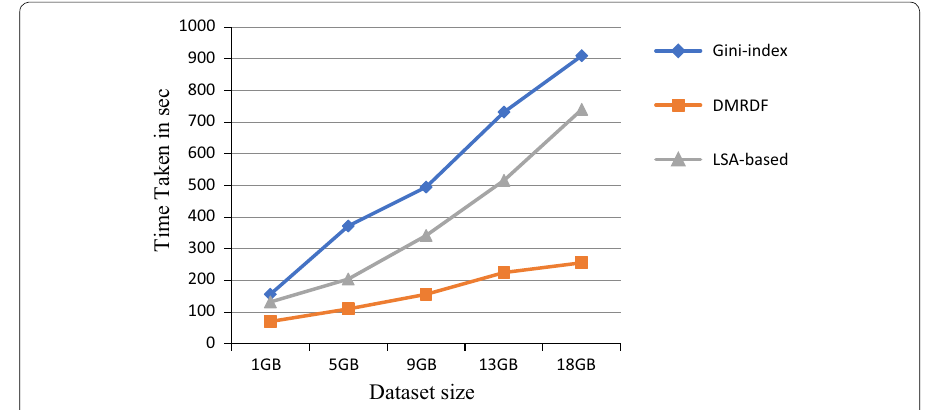
Fig. 3 Dataset Size versus Processing Time Graph